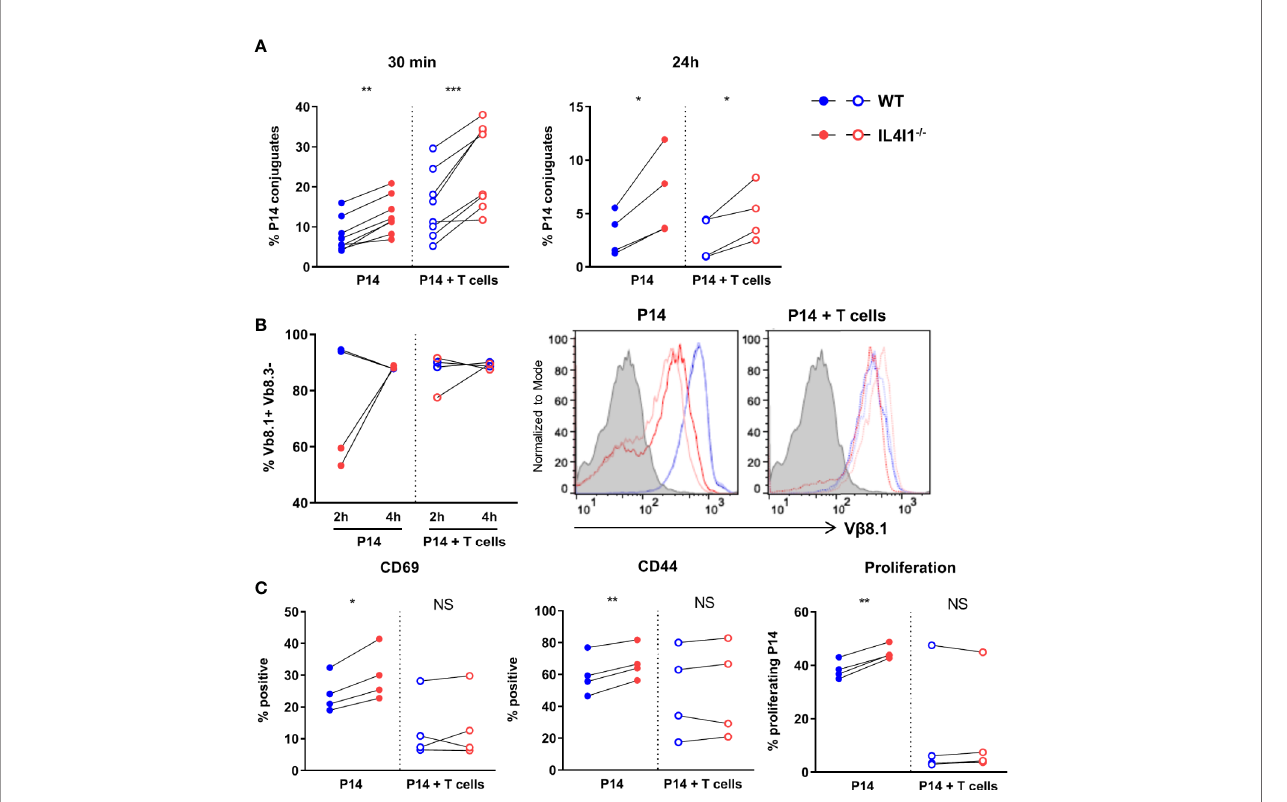
FIGURE 6 | Activation of P14 clonal T cells by DCs in the presence of naïve polyclonal T cells. DCs from WT (blue) and IL4I1 -/- (red) mice presenting GP33 were obtained as in Figure 5 and used to activate sorted P14 CD8 + T cells at a 1:10 ratio in the presence (empty circles) or absence (plain circles) of polyclonal T CD8 + cells sorted from a congenic naïve WT mouse (P14 cell:total T cell ratio = 1:5). (A) The percentage of P14 cells forming conjugates with GP33-pulsed DCs was measured as in Figure 5E at 30 min and 24 h. Individual results from, four and two independent experiments performed in duplicate, respectively. Pairing was based on the purity of the sorted DC populations. (B) Surface expression of the TCR V b 8.1 chain by P14 cells was measured 2 and 4 h after activation in one experiment from panel A (2 tests per condition and time point). Left: percentage of V b 8.1 + V b 8.3 - cells in CD8 + T cells; right: corresponding raw fl ow cytometry data (grey histogram: negative control). (C) The percentage of CD45.1 + P14 cells expressing CD69 and CD44 and that of proliferating P14 cells were measured as in Figure 5 . Results from four independent experiments in duplicate. NS, not signi fi cant; * p < 0.05, ** p < 0.005, *** p < 0.001 (Paired